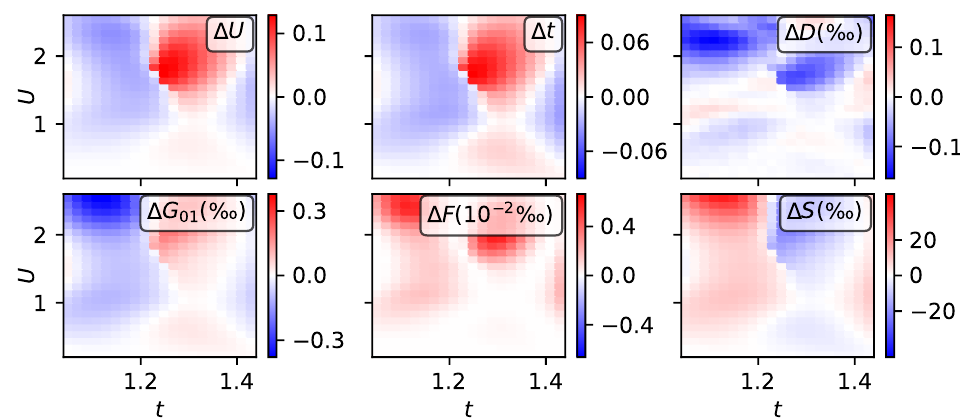
Figure 8: (Color online) Error in finding the correct minimum of the free energy for V = 0.